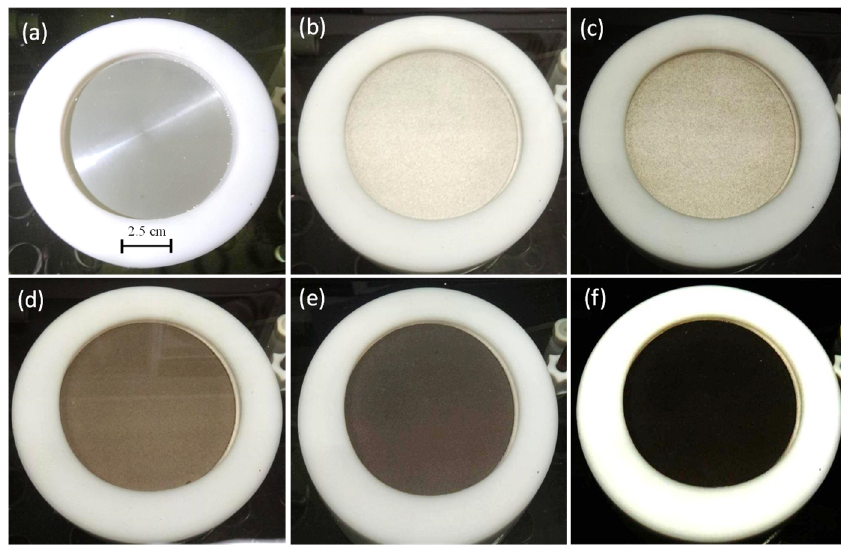
Figure 5. Actual photos of surface color change on AISI 1045 steel/thermal sprayed Al during hard anodization in ( a ) 1 min, ( b ) 10 min, ( c ) 20 min, ( d ) 0.5 h, ( e ) 1 h, and ( f ) 1.5 h.